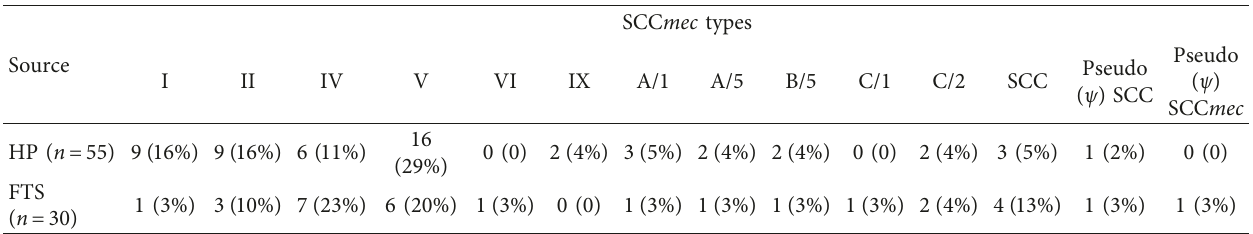
Table 2: SCC mec elements determined in hospital personnel and frequently touched surfaces.